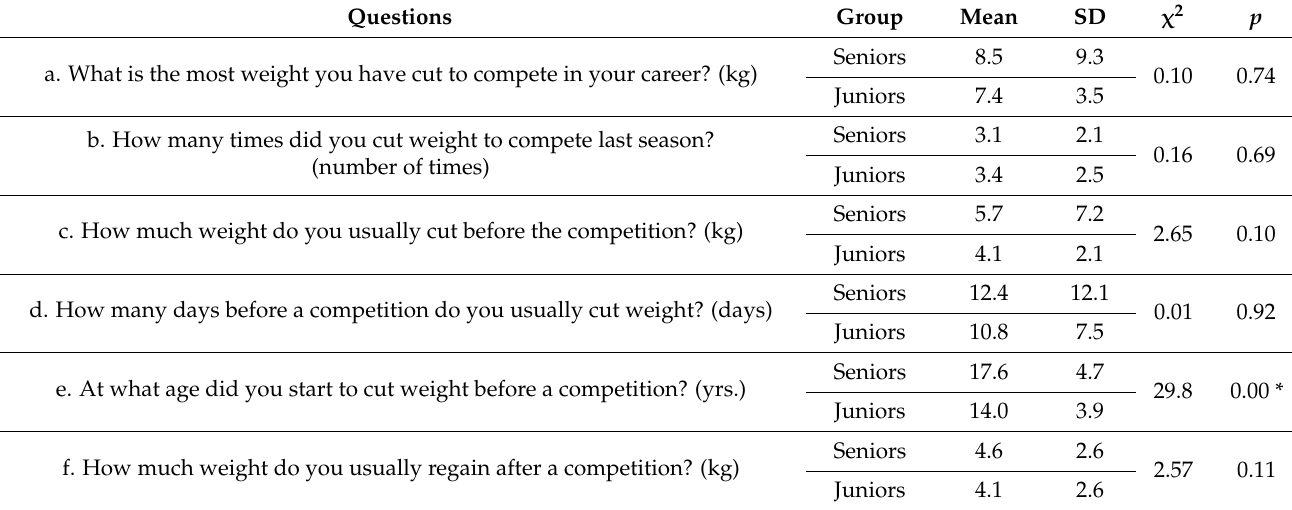
Table 2. Weight reduction history reported by two categories sambo competitors.